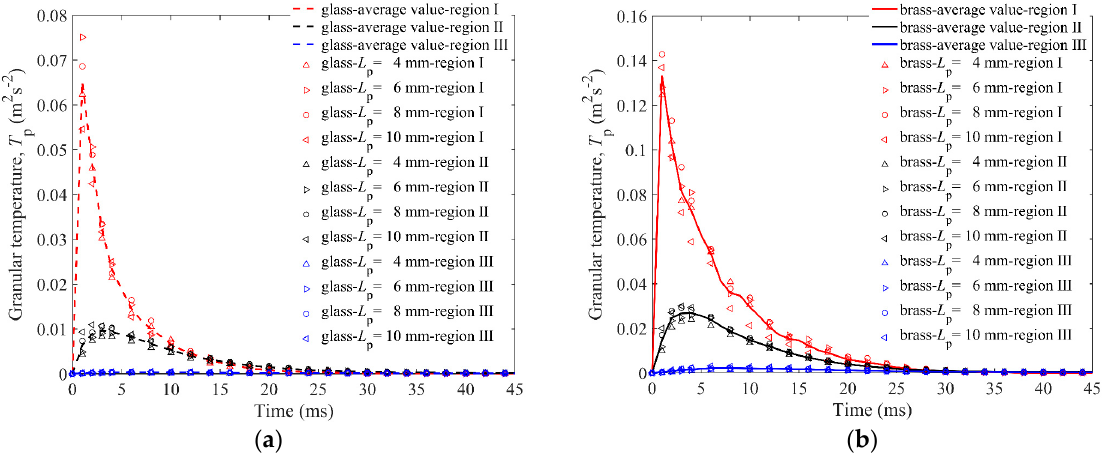
Figure 11. Granular temperature T p of particles in three regions versus time for granular bed with L p = 4 mm, 6 mm, 8 mm, 10 mm elongated particles: ( a ) is for the glass impactor, and ( b ) is for the brass impactor. brass